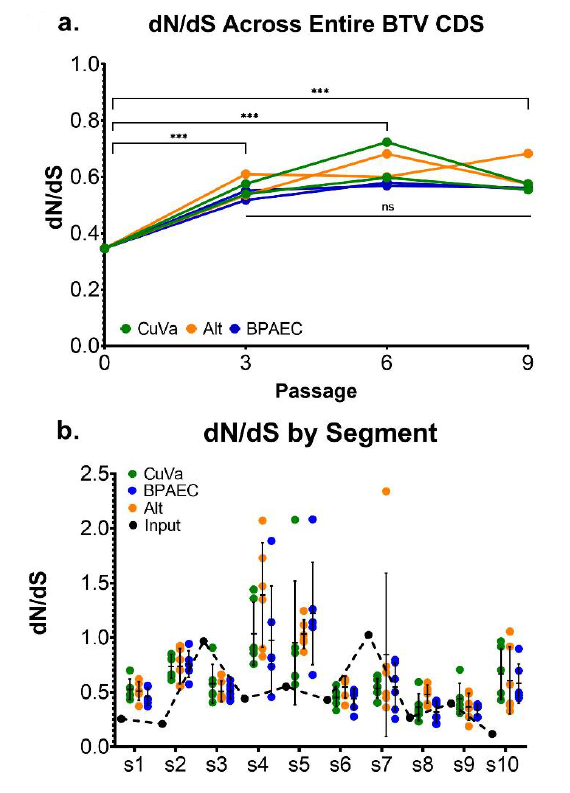
Figure 7. Genetic Selection by Segment and Cell Culture Condition. The proportion of nonsynonymous (dN) to synonymous (dS) changes was used as an estimate of selection. ( a ) dN / dS for each sample was calculated across the entire BTV coding sequence (CDS; inclusive of all ten segments), *** = p < 0.0005. ( b ) dN / dS from all passages and replicates are shown. Error bars depict mean and standard deviation of each segment according to cell culture condition. BTV17-INPUT is shown by black dots and the dashed line. Segments 1–10 are represented along the x -axis (s1, s2, s3, s4, s5, s6, s7, s8, s9, and